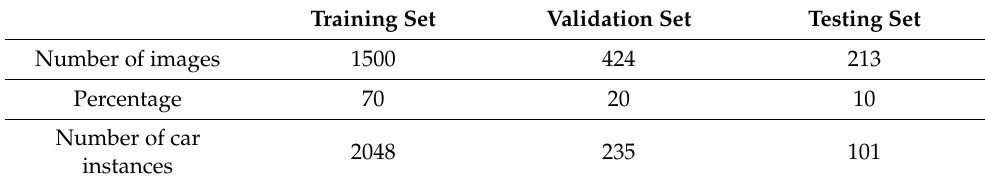
Table 2. Number of images and car instances in our Augmented DAWN